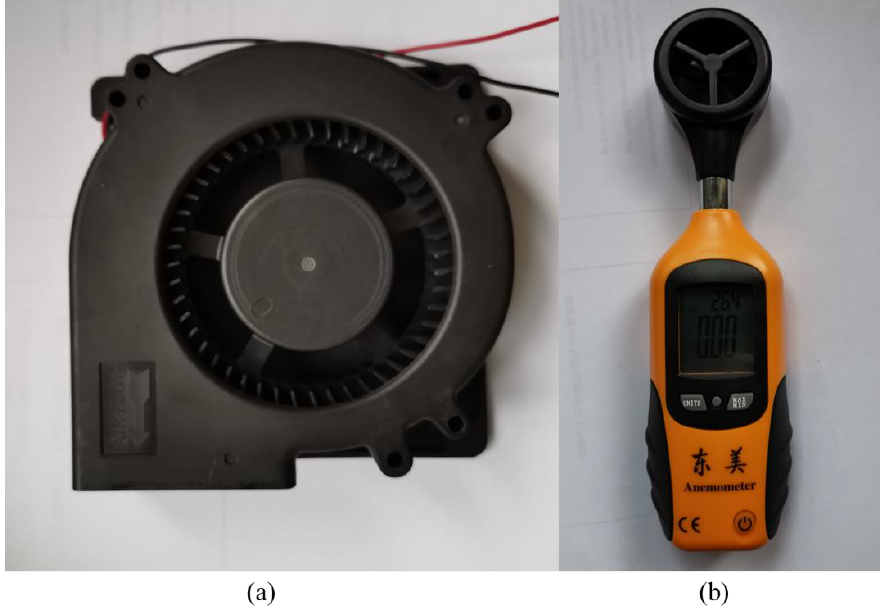
Figure 6. The blower ( a ) and anemometer ( b ) used in experiment.